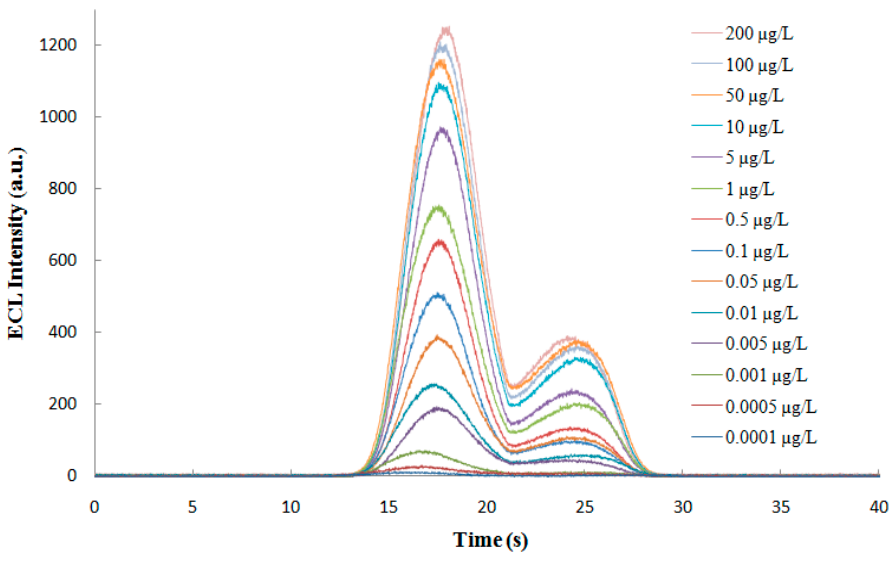
Figure 12. ECL spectra for the ricin detection at different concentrations.